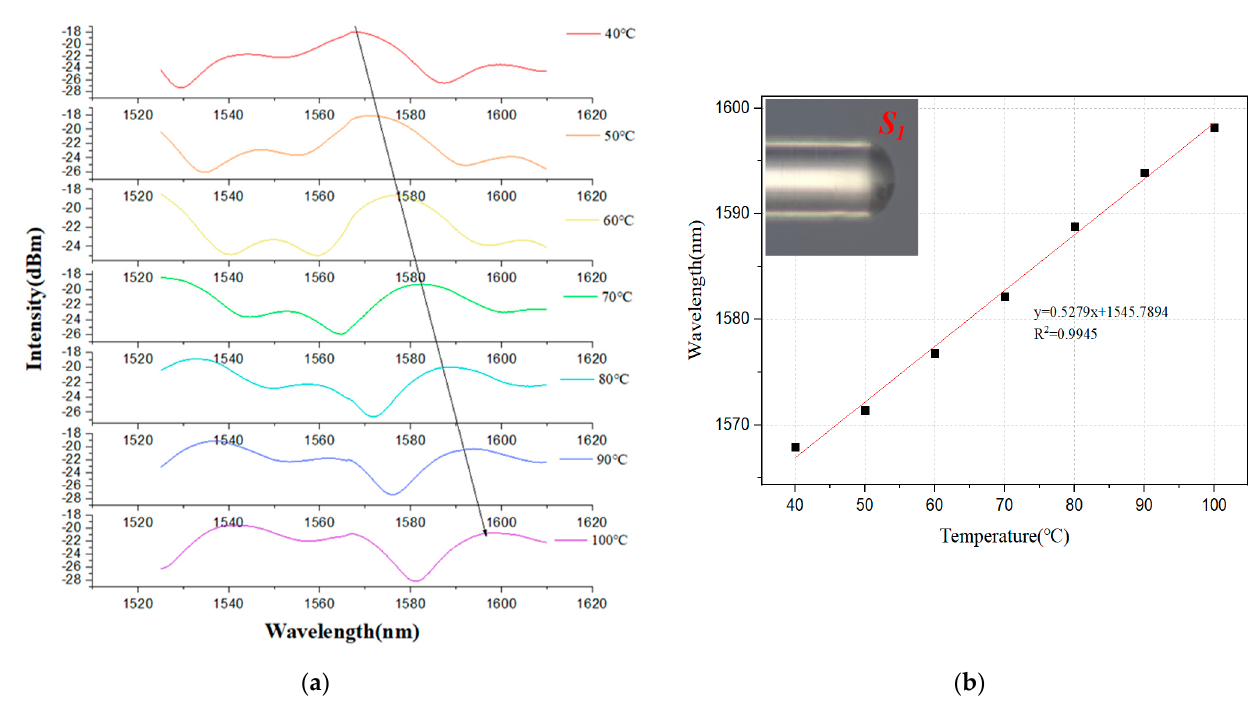
Figure 6. ( a ) The temperature (ranging from 40 to 100 °C, in strides of 10 °C) response interference spectrum of S 1 (AB/PDMS); and ( b ) the temperature sensitivity of S 1 .